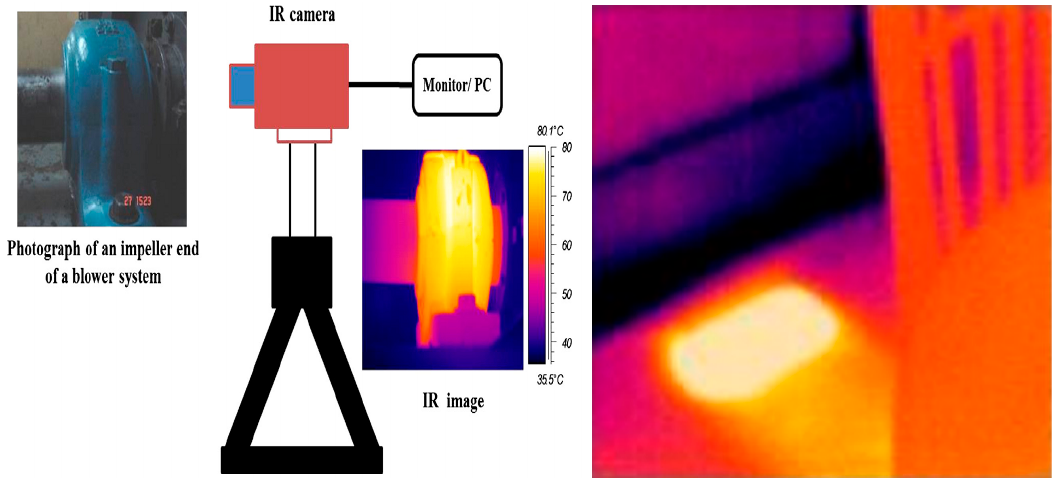
Figure 6. Experimental setup of IRT based system for anomalies monitoring [30,76].